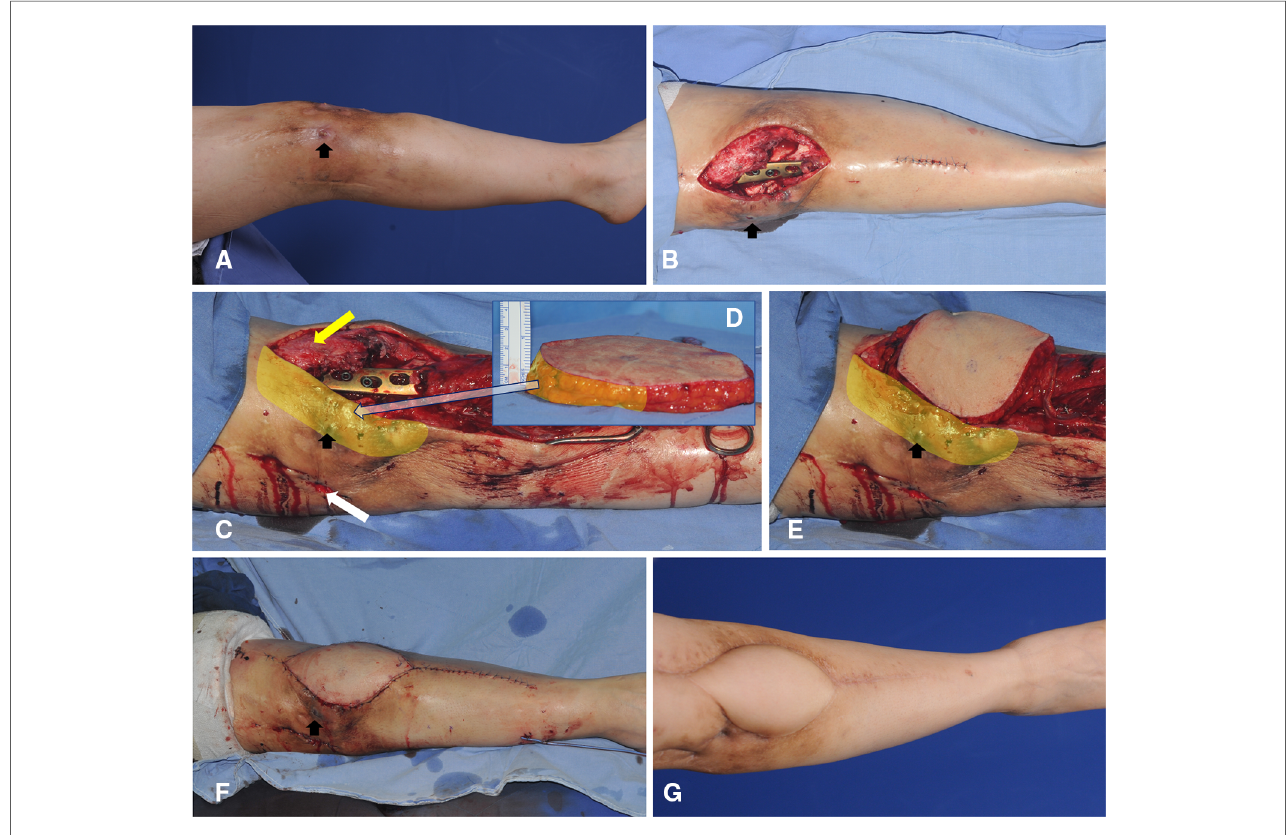
FIGURE 8 A clinical case demonstrating free transfer of Cen-ALTP fl ap using ATA and its concomitant veins as recipient vessels for the soft-tissue reconstruction around the knee (case No.3; Algorithmic option No.4; Black arrow indicates the sinus tract which communicates between underlying infected bones by osteomyelitis and overlying skin) ( A ) Damaged soft-tissue around knee joint was observed in a 49-year-old female patient suffering from chronic osteomyelitis. ( B ) The soft- tissue defect was created after radical debridement. The defect size was relatively small. ( C,D ) Orthopedic surgeons performed bony debridement through anterior (Yellow arrow) and lateral (White arrow) incisions. Plastic surgeons debrided damaged soft tissues around the anterior incision and preserved soft tissues between anterior and lateral incisions to limit the defect size to the optimal size range to be reconstructed safely by free ALTP fl ap. Alternatively, the space between infected bones and overlying soft tissues between anterior and lateral incisions was thoroughly cleaned up and occupied by healthy soft tissues of the transferred ALTP fl ap. ( E,F ) Cen-ALTP fl ap with a small round skin paddle (15×12 cm 2 ) was harvested and transferred with the fl ap pedicle and was anastomosed to ATA and its concomitant veins. ( G ) Result 4 months postoperatively. (ALTP, anterolateral thigh perforator; Cen-ALTP fl ap, ALTP fl ap with centrally located perforators; ATA, anterior tibial